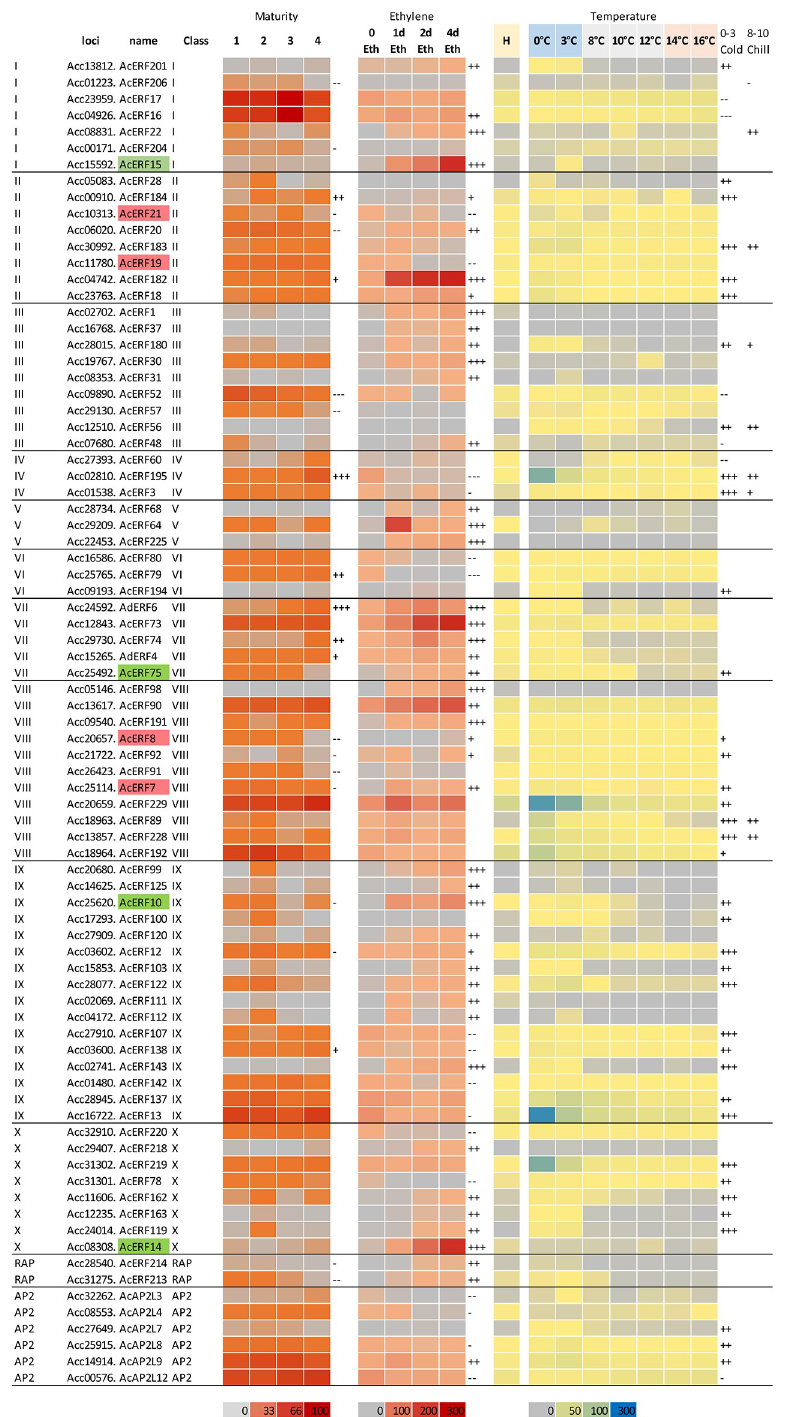
Fig 4. RNA-seq expression analysis. 81 ERF/AP2-like genes that show a medium or strong change in expression during Actinidia chinensis var. chinensis ‘Hort16A’ fruit maturation and following ethylene (100ppm) and temperature treatments. + indicates the genes are activated, and—that the genes are repressed. Gene names in red represent genes previously suggested to be repressors of ripening, while gene names in green represent proposed activators.